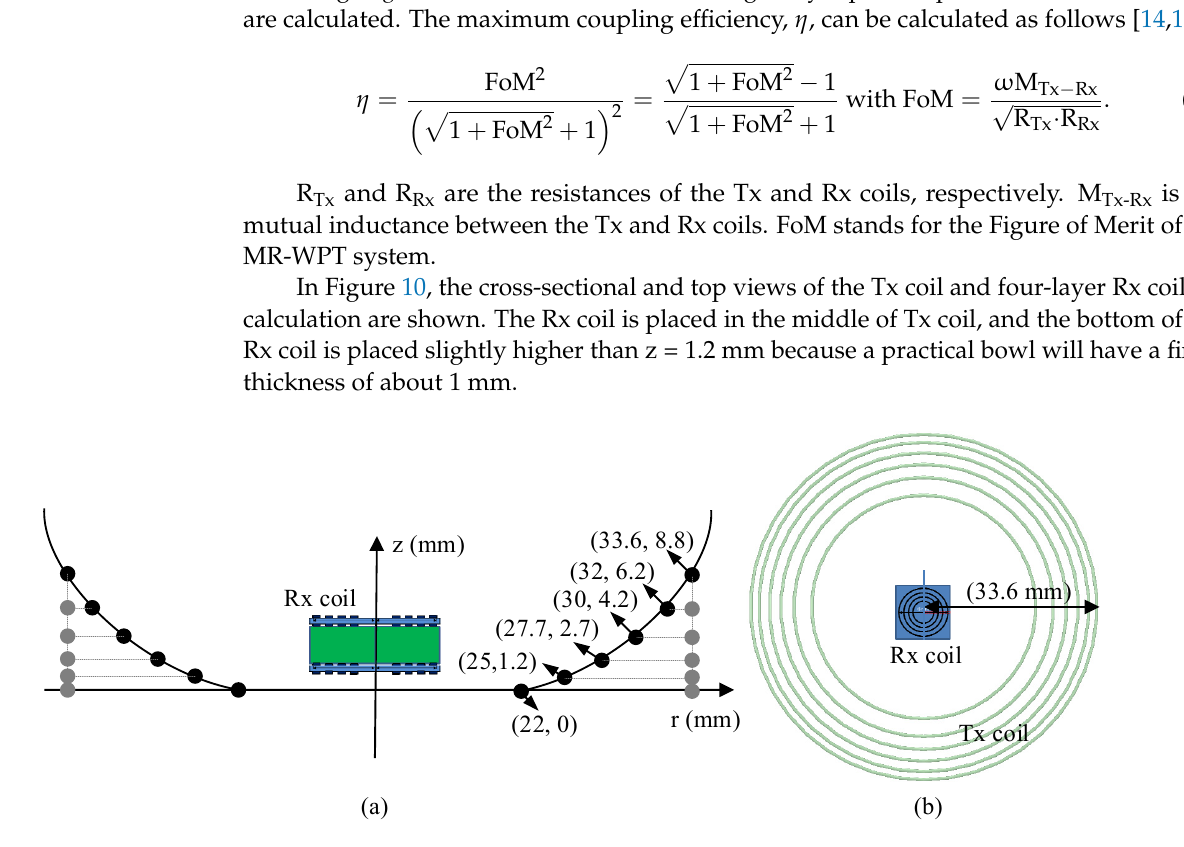
Figure 10. ( a ) The cross-sectional and ( b ) top views of the glass-shaped Tx coil and four-layer Rx coil for calculation. In the cross-sectional view, a helical coil is also displayed (gray color).